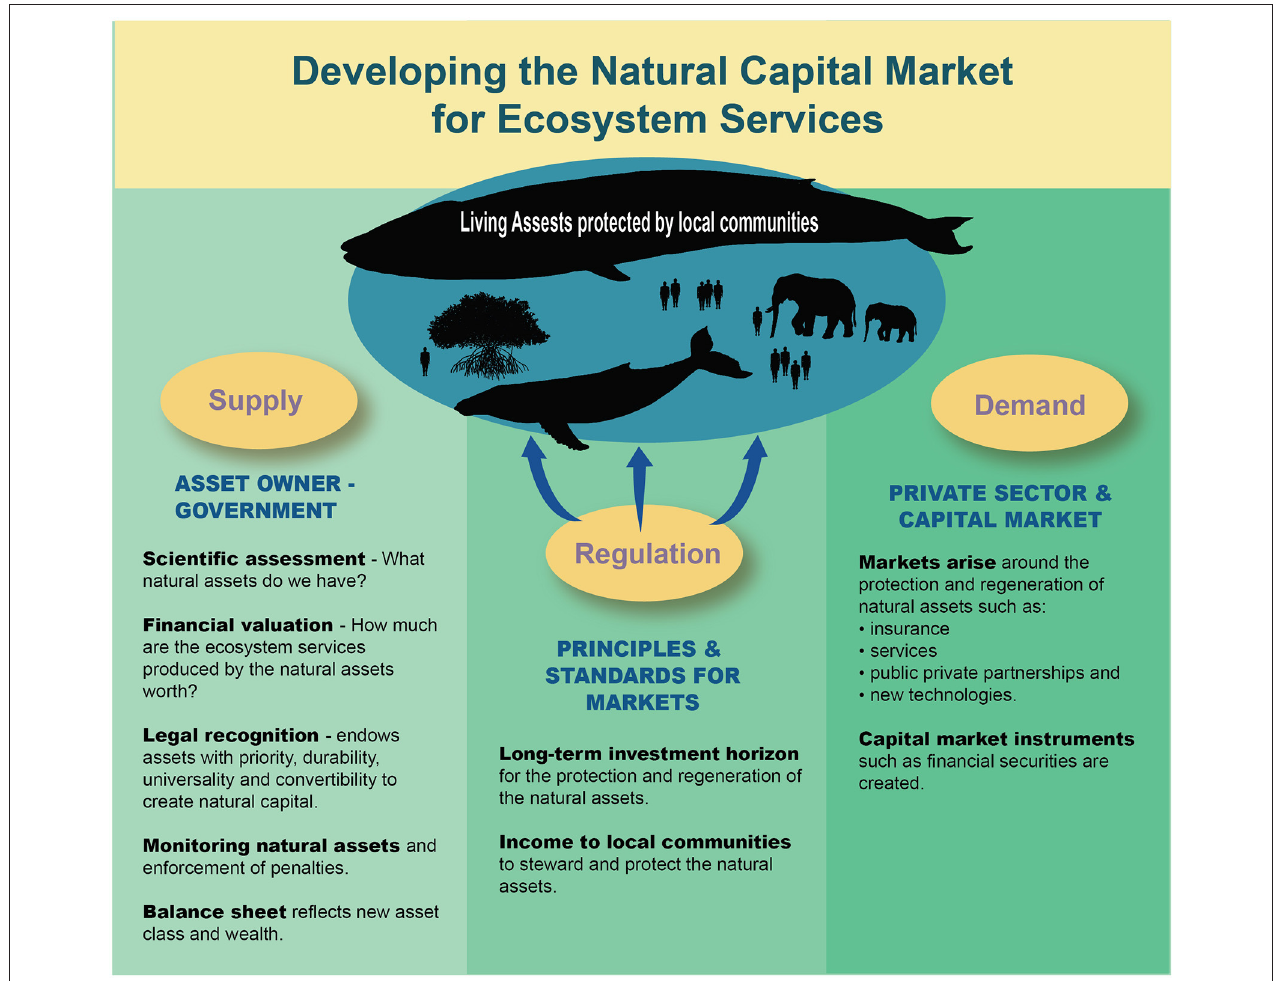
FIGURE 2 | Developing the natural capital